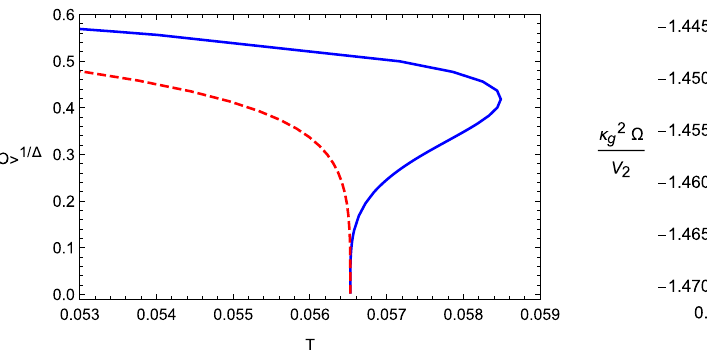
dashed red line for the p + ip solution. The solid black line denote the grand potential curve for the normal solution without any condensate